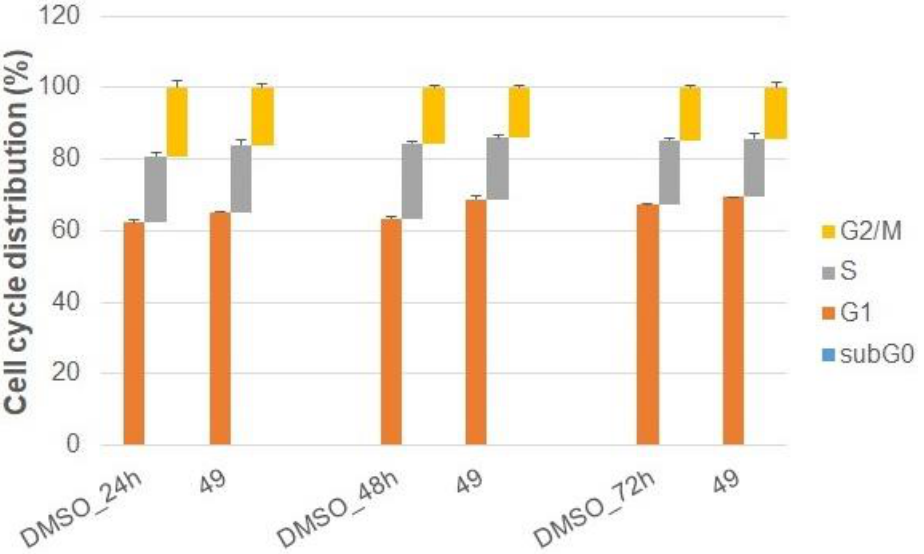
Figure 2. Effect of compound 49 on the cell cycle progression of A549 cells after 24, 48 and 72 h incubation. The data show the mean ± SD values of three independent experiments.